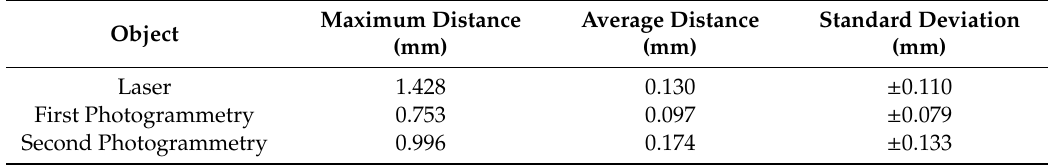
Table 3. Statistical indices obtained from the comparisons between the printed models and the original